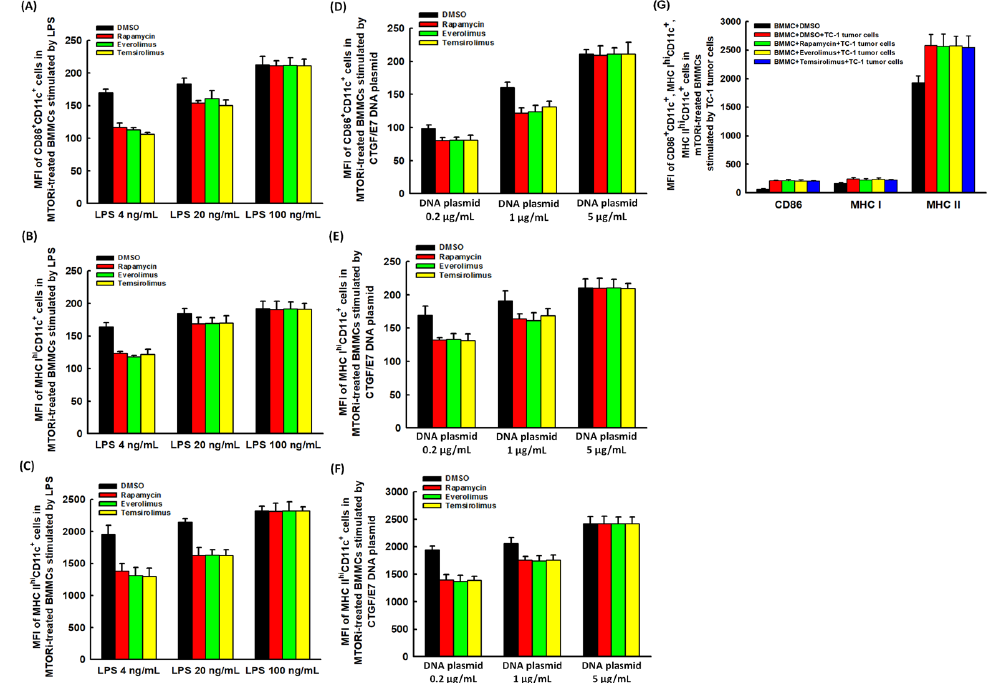
Figure 2. DC maturation markers expressed on mTORi-treated BMMCs could be modulated. ( A–C )